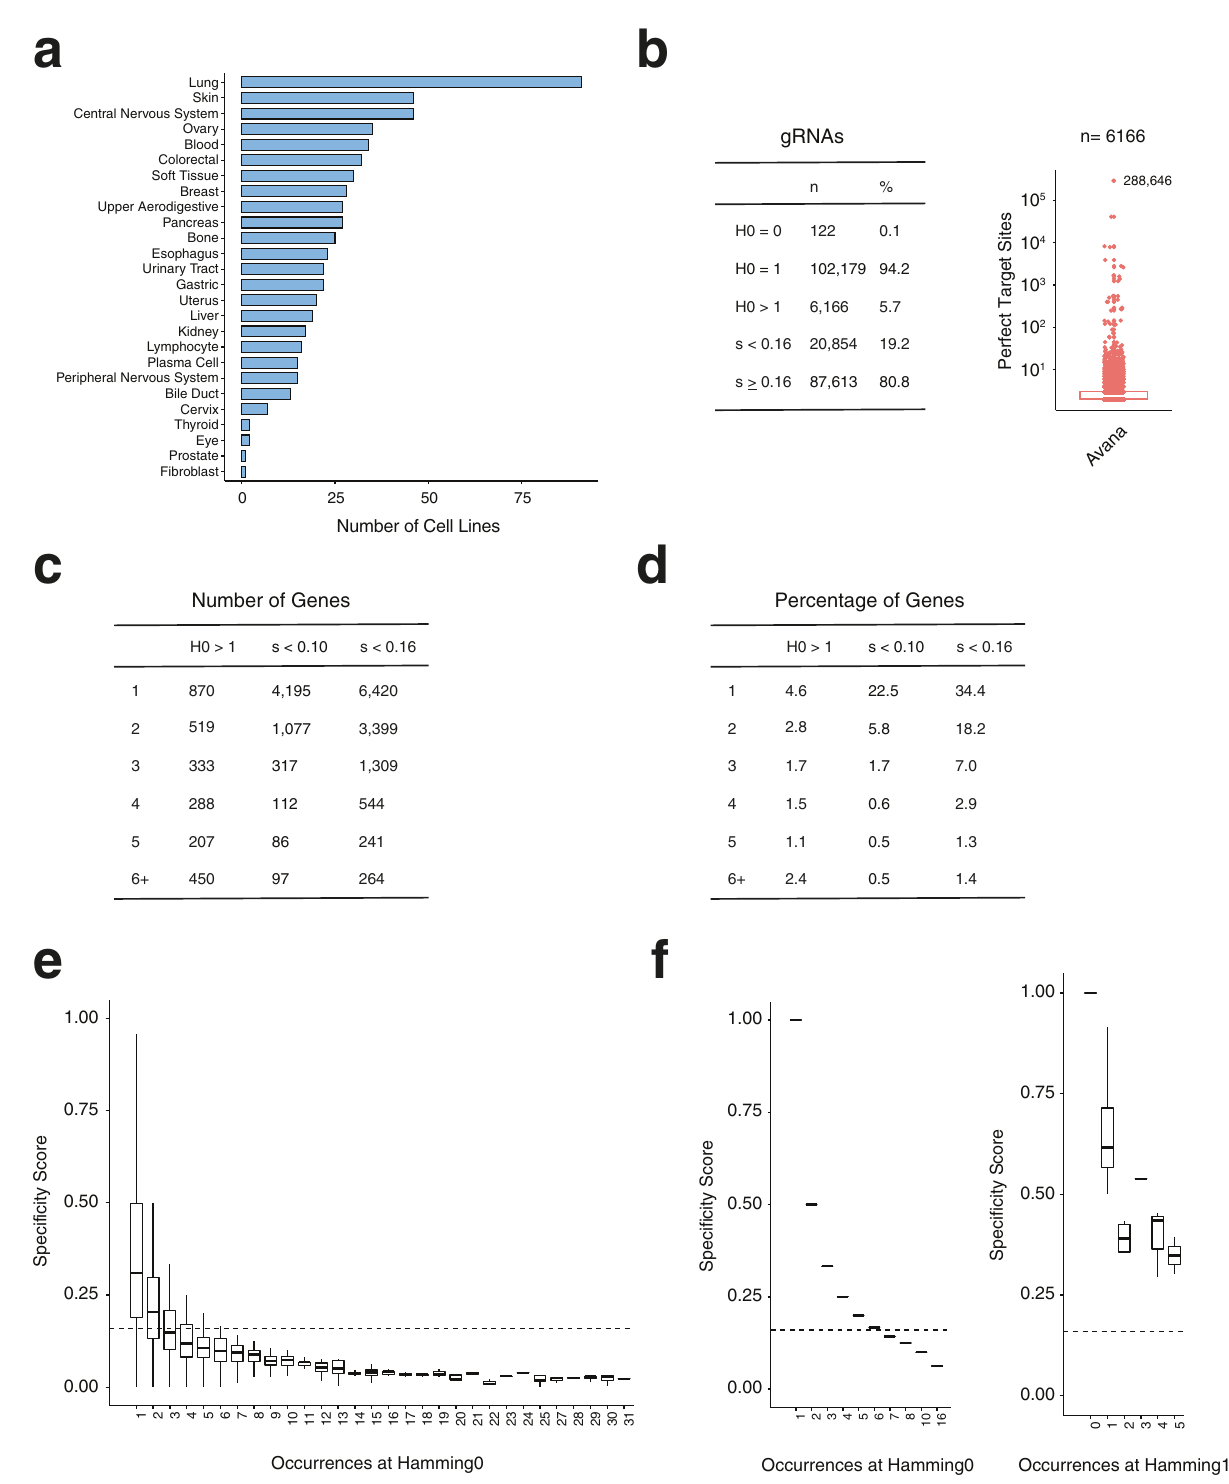
Fig. 1 Analysis of the 19Q4 Avana dataset from the DepMap initiative. a Number of screened cell lines in each of the 26 lineages represented in